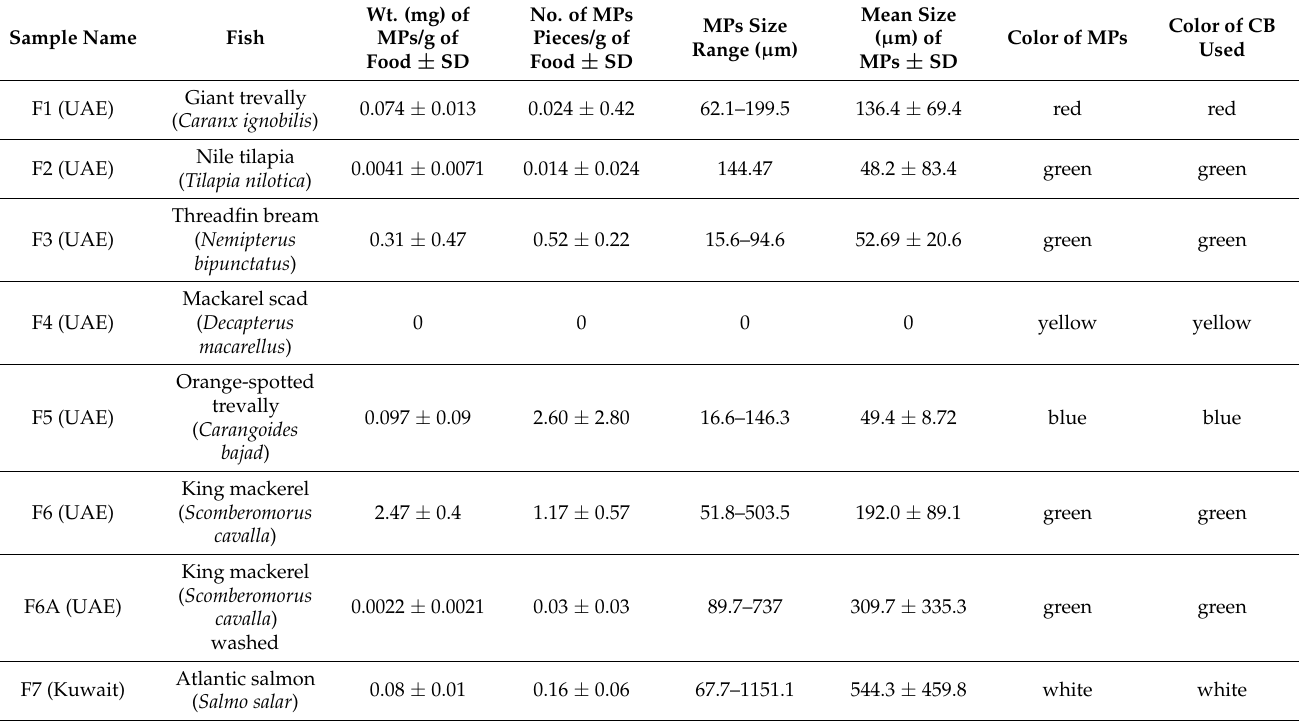
Table 2. Size distribution and characterization of MPs in fish